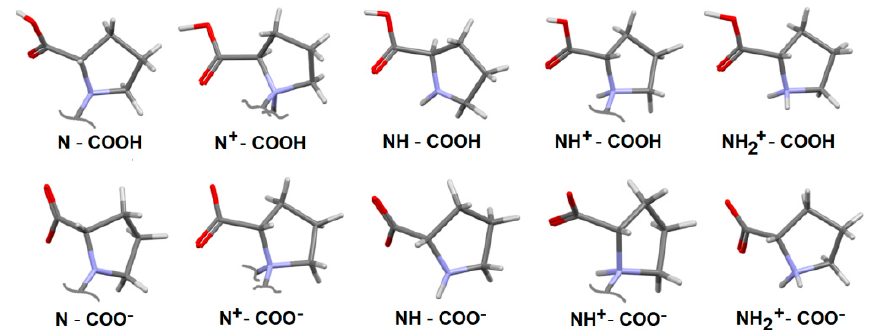
Figure 1. Neutral, zwitterionic, cationic and anionic forms of proline moieties as identified in 2366 relevant structures retrieved from the Cambridge Structure Database (CSD) ([157]; CSD, ver. 5.41,